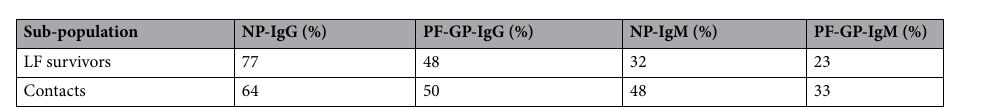
Table 1. The seroprevalence of LASV GP and NP binding antibody (IgG and IgM) response among survivors and their contacts in Southern Nigeria.